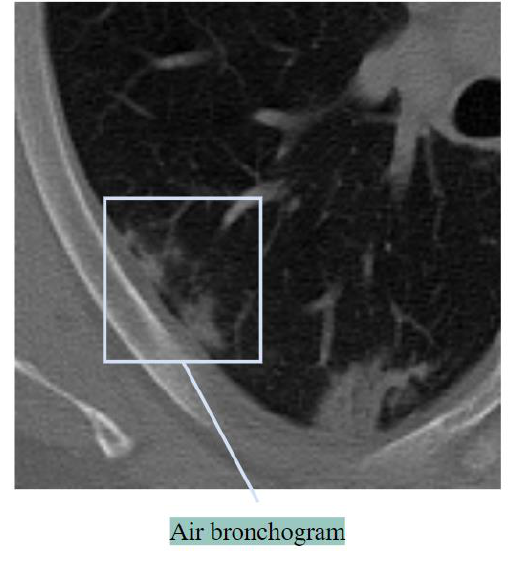
Figure 6. Air Figure 6. Air bronchogram.